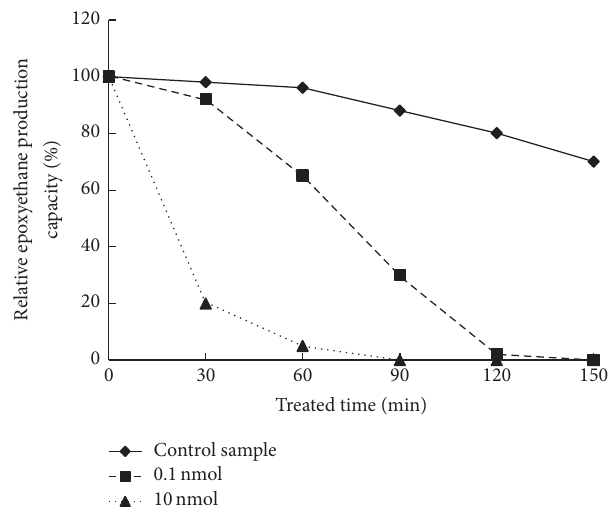
Figure 7: Effect of epoxyethane on relative epoxyethane production capacity. Methylosinus trichosporium IMV 3011 cells were treated with epoxyethane ( 󳵳 10nmol, ◼ 0.1nmol) at various times and epoxyethane production capacity is compared with that of the control sample ( X 0nmol treated). Treatment condition was the same as epoxyethane synthesis